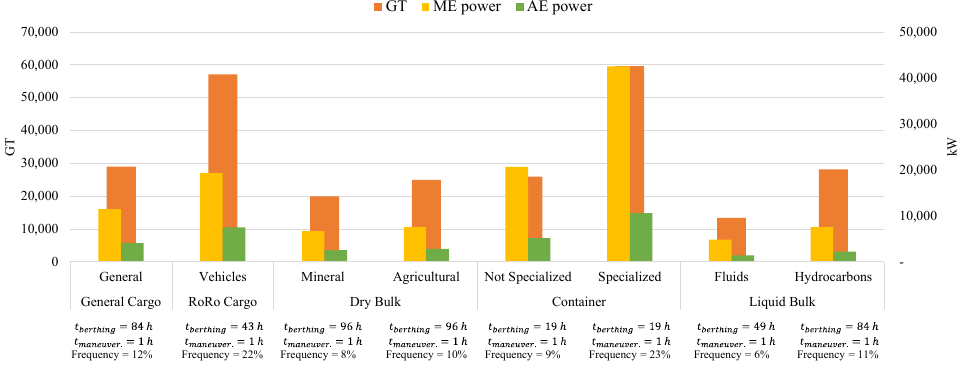
Figure 3. Parameters to determine atmospheric emissions by type of ship.